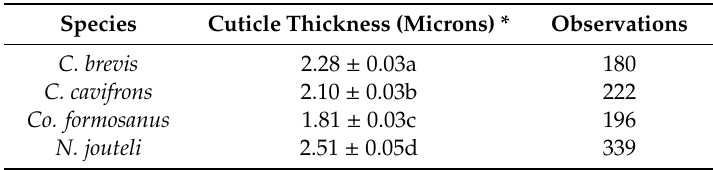
Table 2. Rectal pad widths (mean ± SEM) of four termite Table 1. Cuticle thicknesses (mean ± SEM) of four termite species.